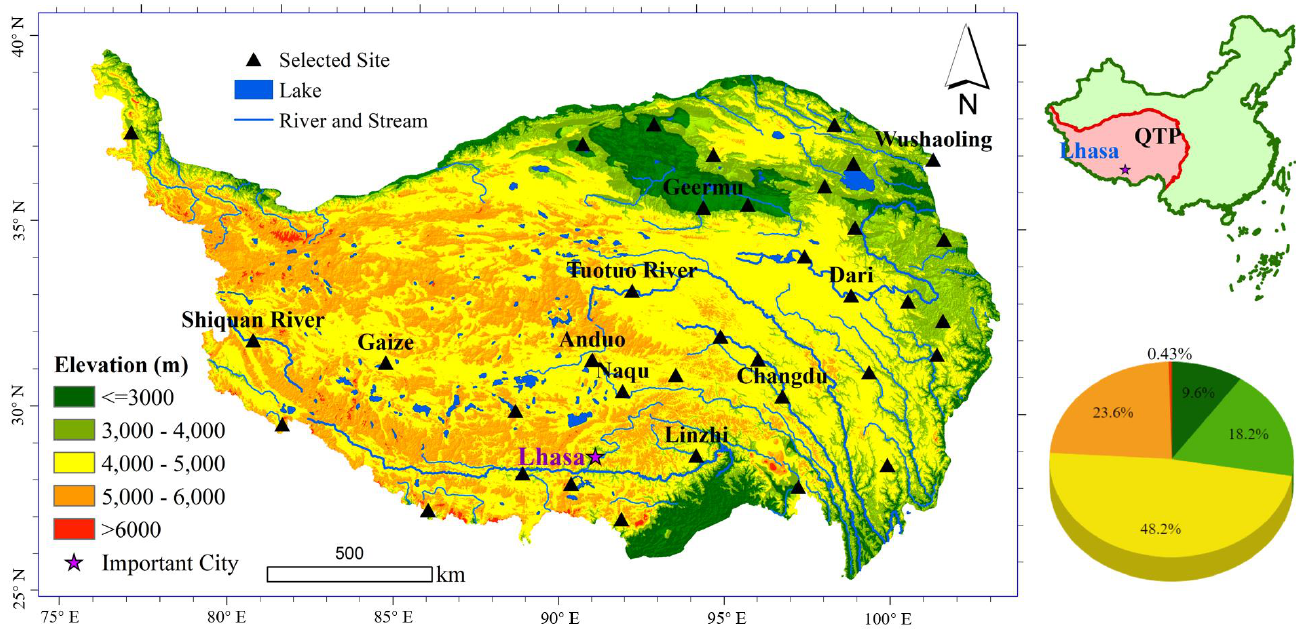
Figure 1. Map showing the location and topography of the Qinghai-Tibet Plateau (QTP) and the sites under investigation. The pie chart shows the proportions of different elevational zones on the QTP.